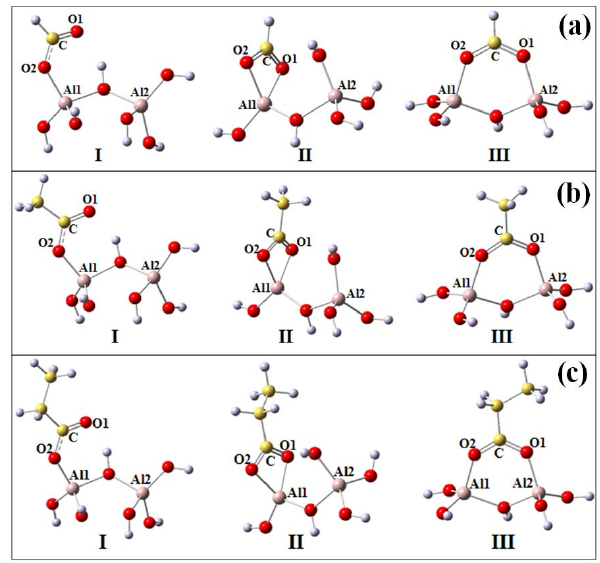
Fig. 4. Optimized structure of the computational models (I–III) for (a) formate, (b) acetate, and (c) propionate species on α -Al 2 O 3 sur- face. Red circles represent O atoms; yellow circles represent C atoms; pink circles represent Al atoms; Gray circles represent H